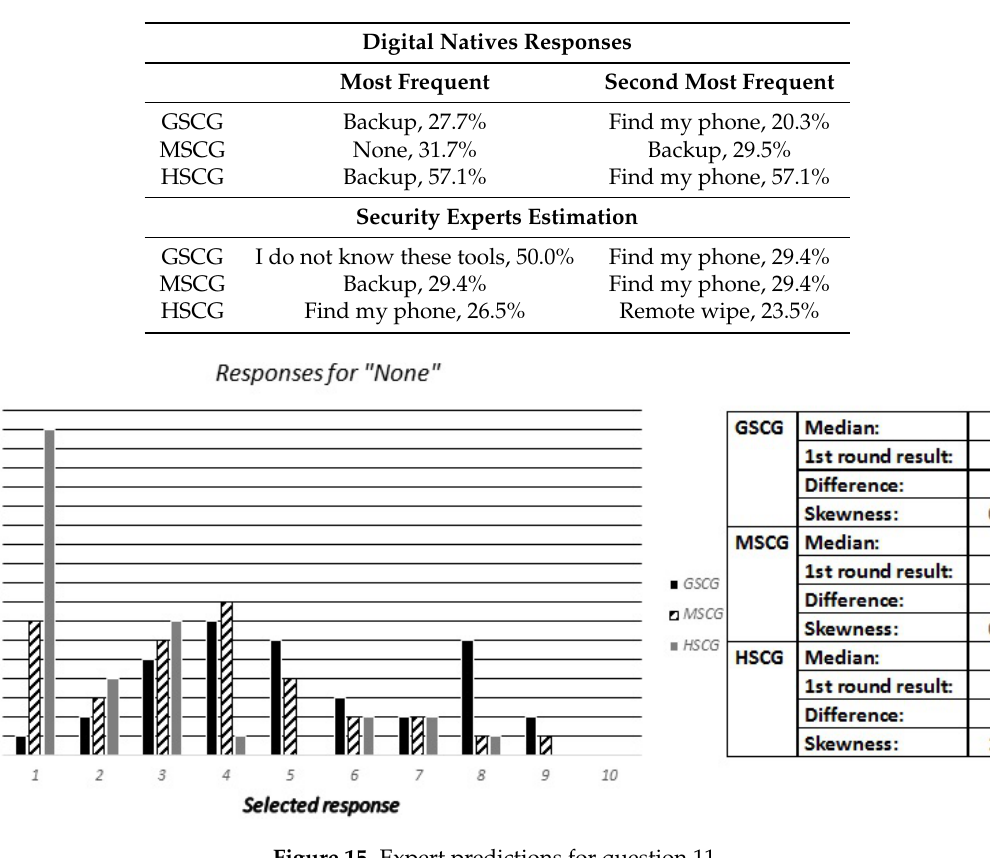
Figure 15. Expert predictions for question 11.